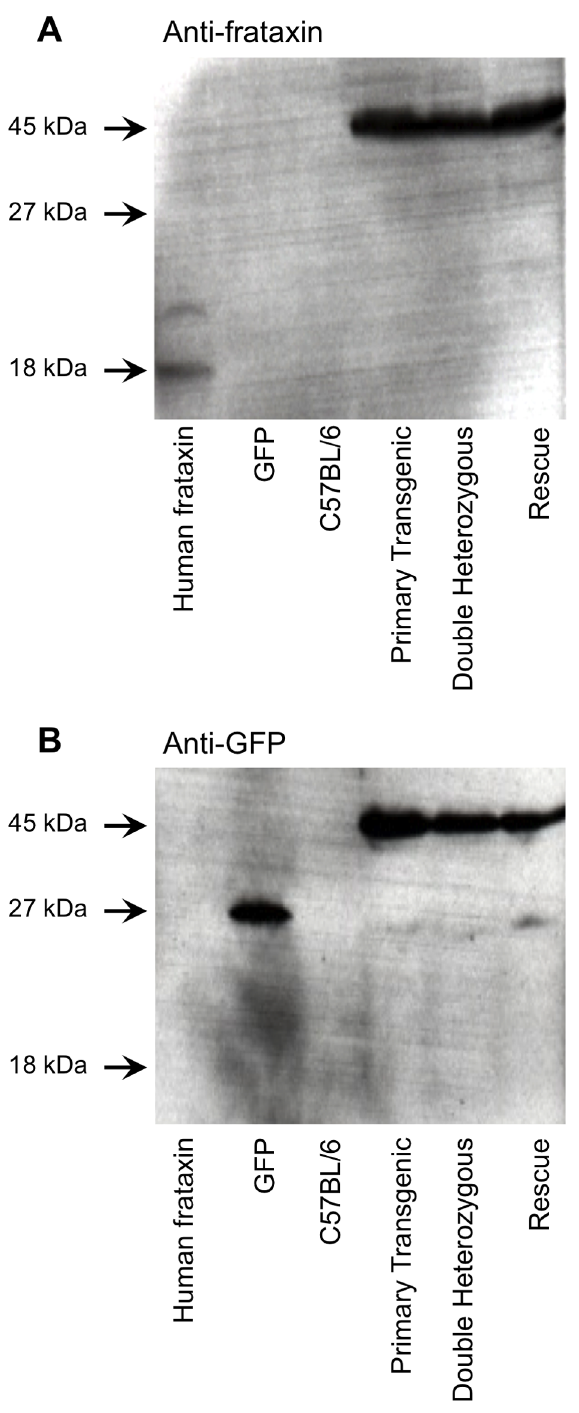
Figure 3. Detection of frataxin-EGFP fusion protein. Western blot analysis was carried out on protein extracts from liver tissue of FXN- EGFP transgenic mice and C57BL/6 control mice. Identical blots were probed with either anti-human frataxin monoclonal antibody (A) or with anti-GFP polyclonal antibody (B). A liver cell lysate from a transgenic mouse expressing human frataxin [26] was used as a positive control for the anti-frataxin antibody, and purified recombinant GFP was used as a positive control for the anti-GFP antibody. Both antibodies detected a protein of the expected size of the full-length frataxin-EGFP fusion (45 kDa) in transgenic mice. Cross-reaction of the anti-human frataxin antibody with murine frataxin was not evident